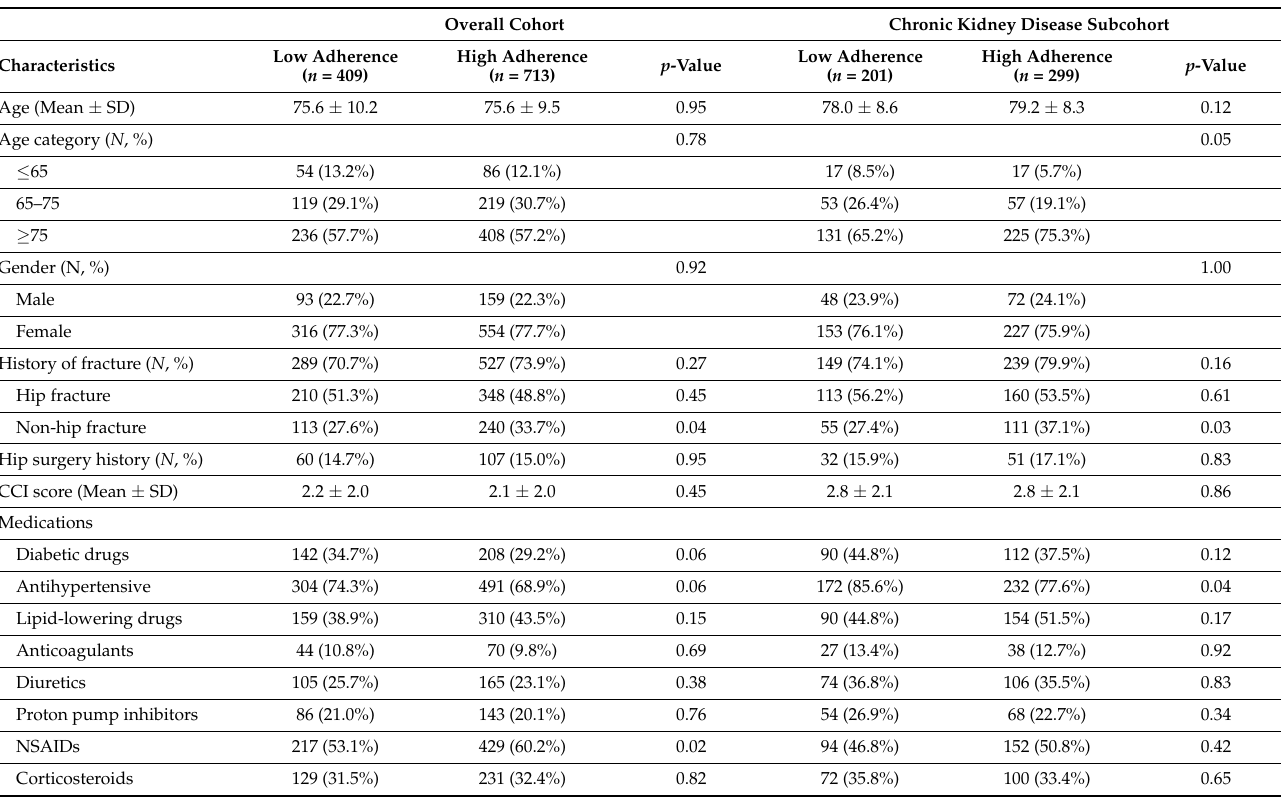
Table 1. Baseline characteristics of new denosumab users in the overall cohort and chronic kidney disease subcohort.